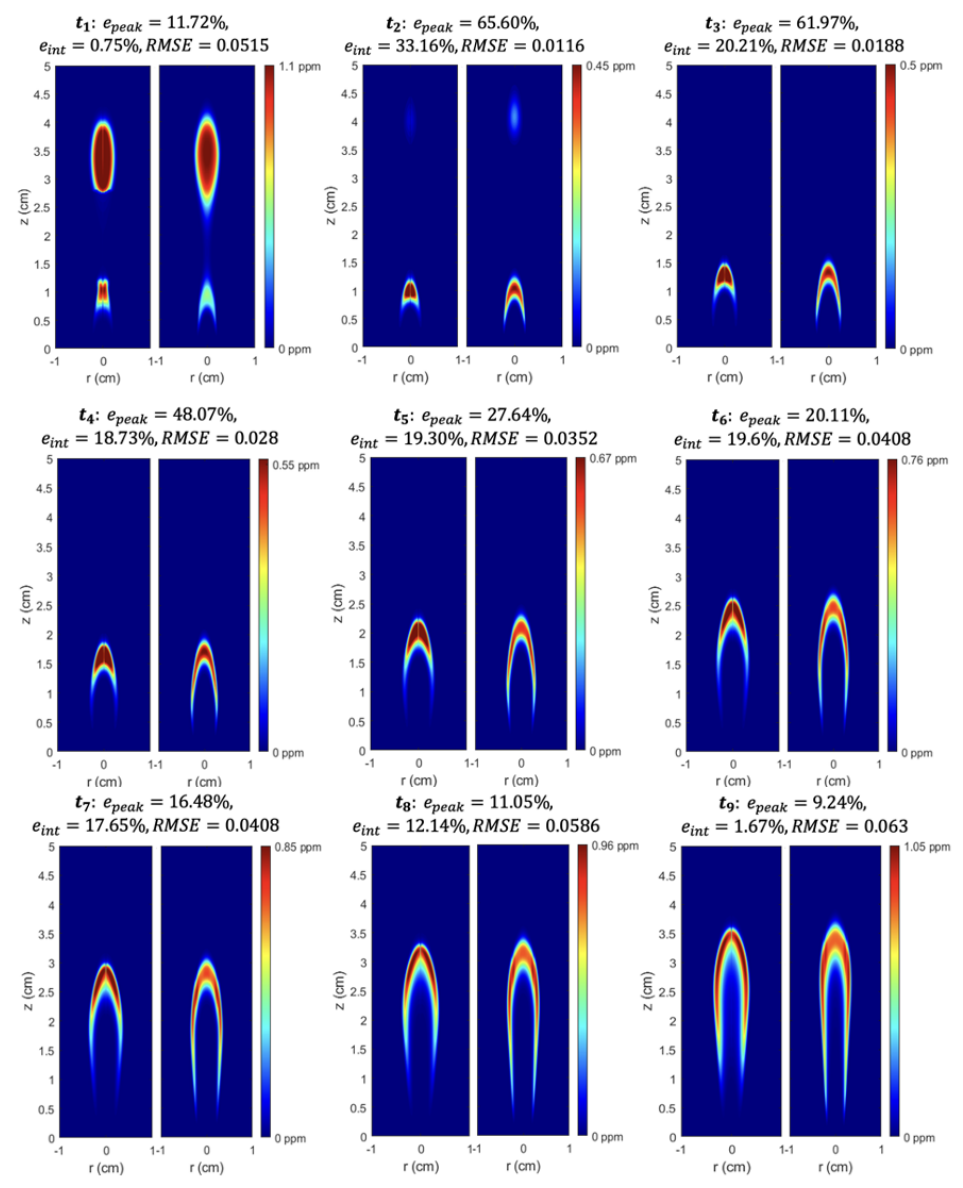
Figure 7. Soot volume fraction f v (ppm) compared at different time steps between CFD and the neural network (training data only). Left: LSTM neural network, right: